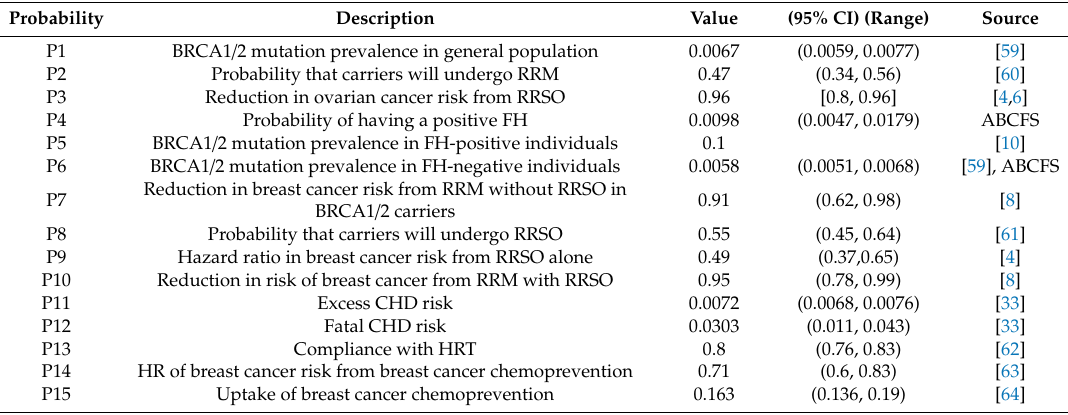
Table 4. Probability